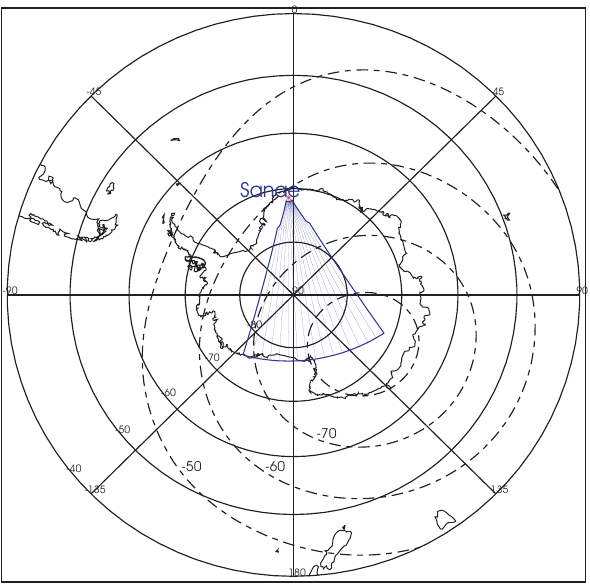
Fig. 3. The SHARE radar field of view in geographic coordinates. Lines of magnetic latitude (dashed) are also